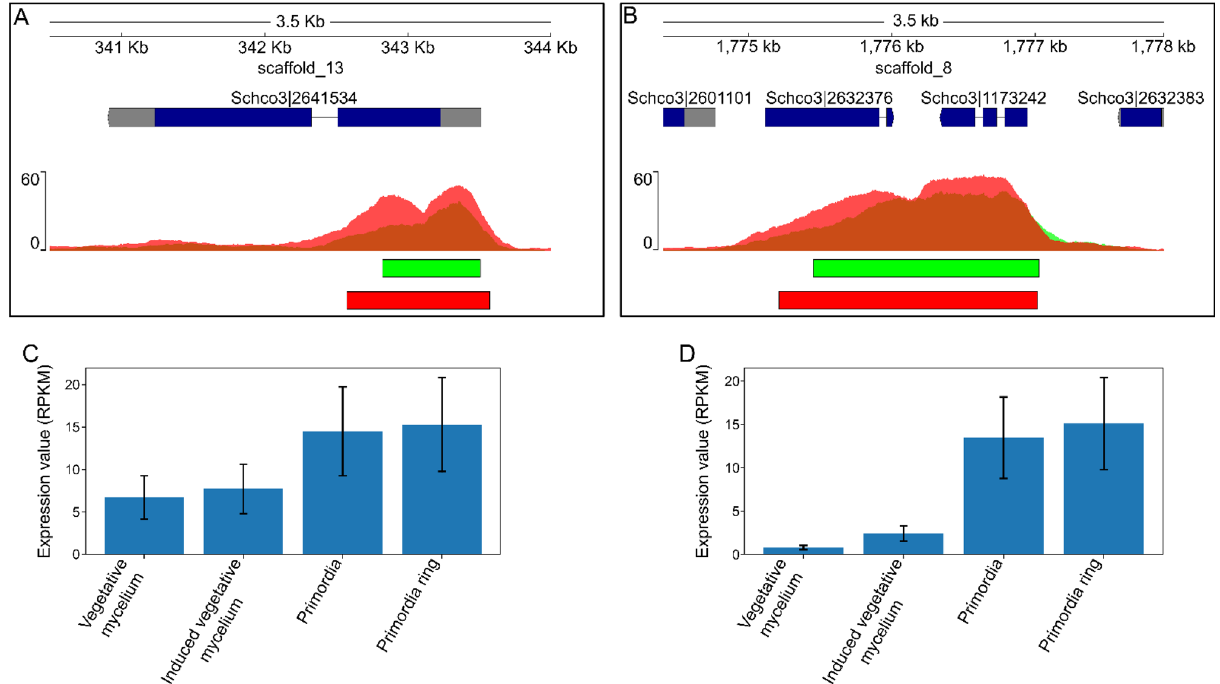
Figure 5. Read depth and expression of the transcription factor genes fst1 (protein ID Schco3|2601101) and zfc7 (protein ID Schco3|2601101). ( A , B ) The normalized read depth of H3K4me2 ChIP during monokaryotic (green) and dikaryotic (red) development in the loci of fst1 ( A ) and zfc7 ( B ). Overlap in read depth is indicated in orange. The identified peaks are indicated below. Both fst1 and zfc7 have increased read depth and broader peaks during dikaryotic development. ( C , D ) Expression of fst1 ( C ) and zfc7 ( D ) during mushroom formation in S. commune 6 . The 95% confidence interval is indicated by black error bars. Both transcription factors have increased expression during primordia